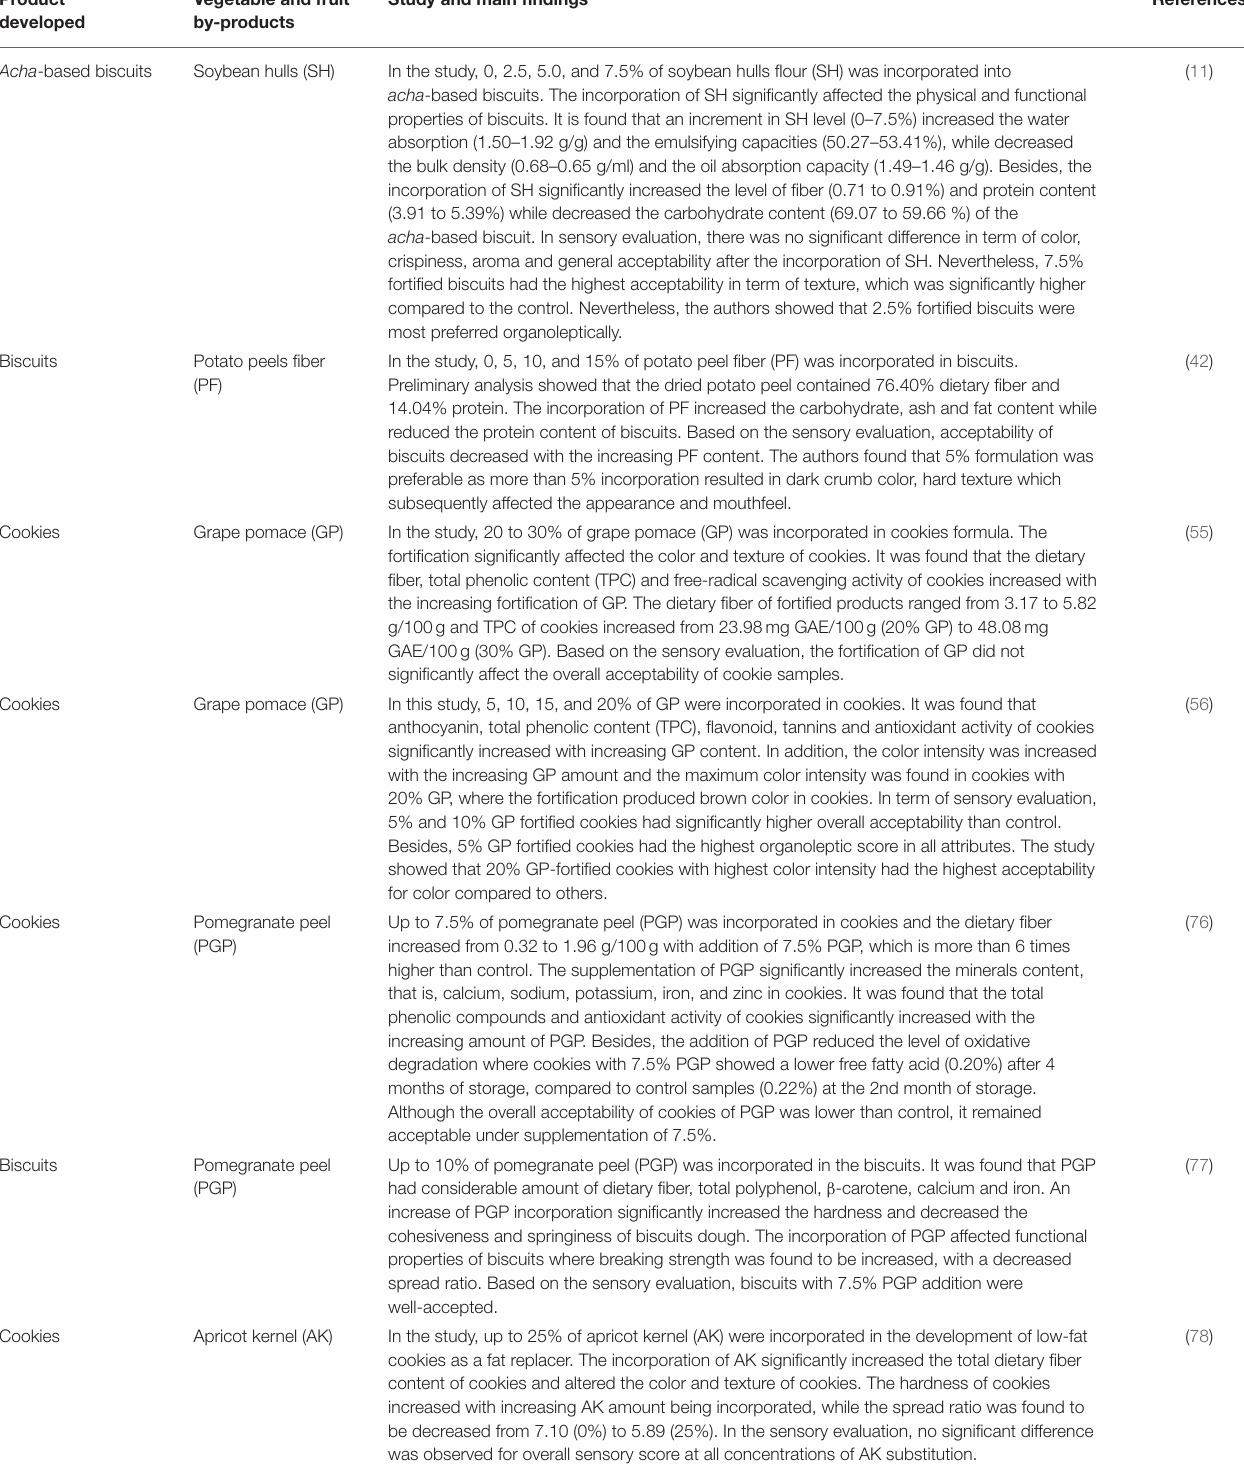
TABLE 2 | Study and main findings of vegetable and fruit by-products utilization as functional ingredients in development of cookies and biscuits.